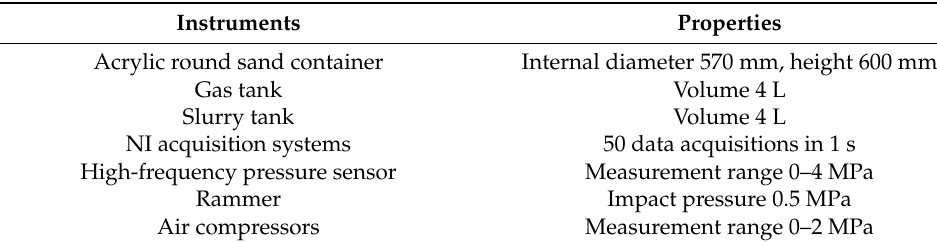
Table 3. Test equipment and instruments.